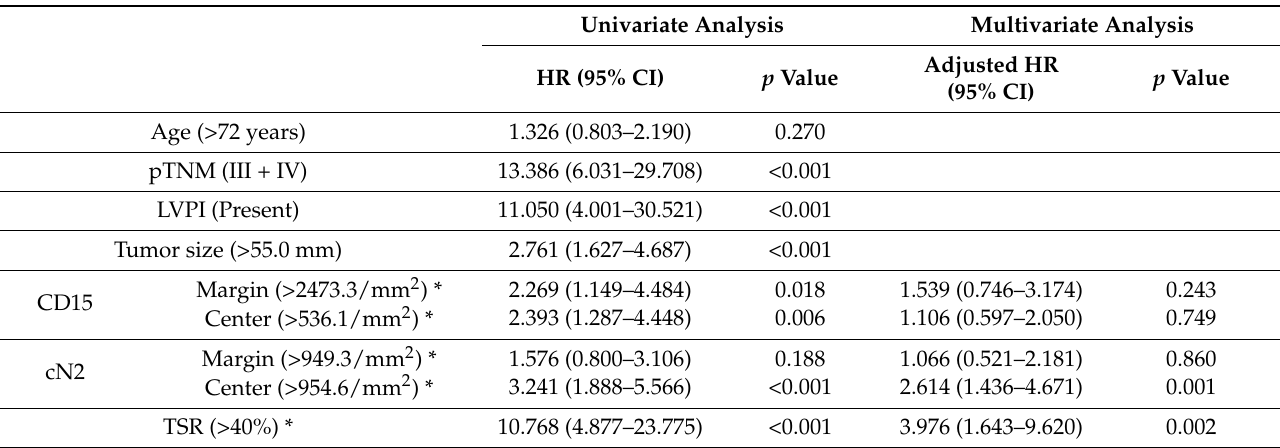
Figure 2. Disease-free survival according to calculated tumor-associated neutrophils for pro-tumor function (cN2) and tumor − stromal ratio (TSR). ( a ) cN2 at the tumor margin; ( b ) cN2 at the tumor center; ( c ) TSR. Table 3. Univariate and multivariate analyses of factors associated with disease-free survival of advanced gastric